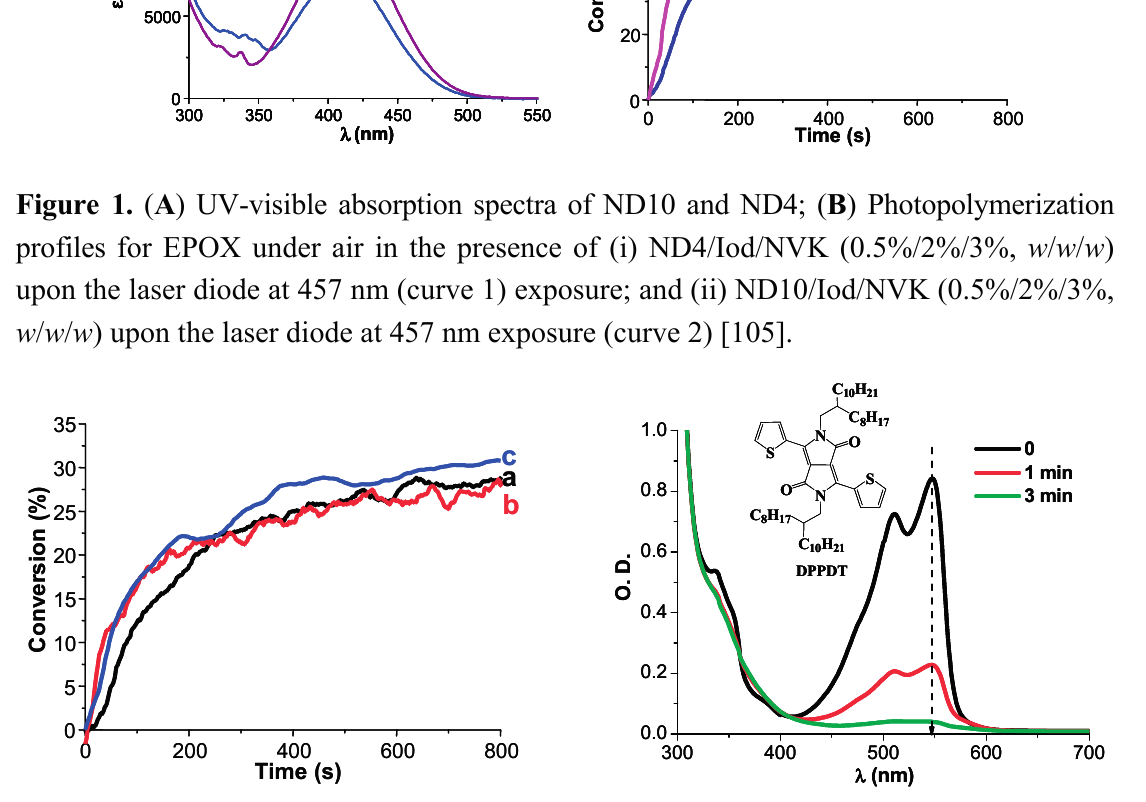
Figure 2. (left part) Photopolymerization profiles of EPOX under air in the presence of DPPDT/Iod (0.5%/2%, w / w ) upon the halogen lamp (a) and laser diode at 532 nm (b); DPPDT/Iod/NVK (0.5%/2%/3%, w / w / w ) upon the laser diode at 532 nm (c); (right